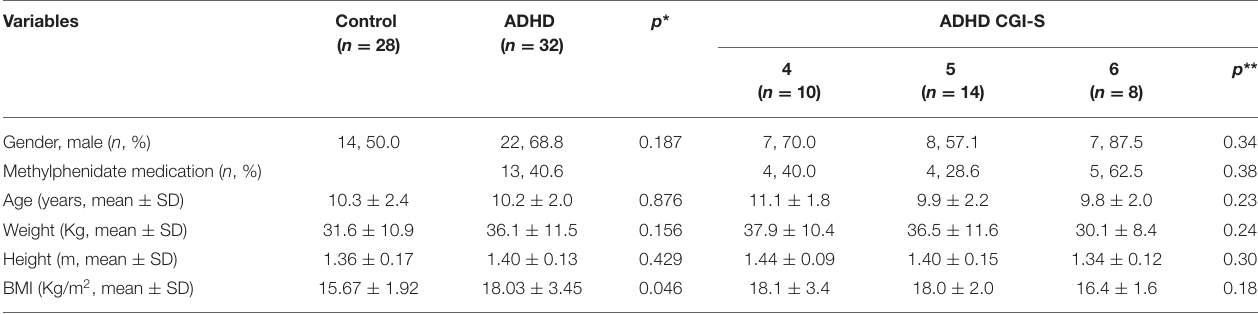
TABLE 1 | Demographic characteristics of the study participants.